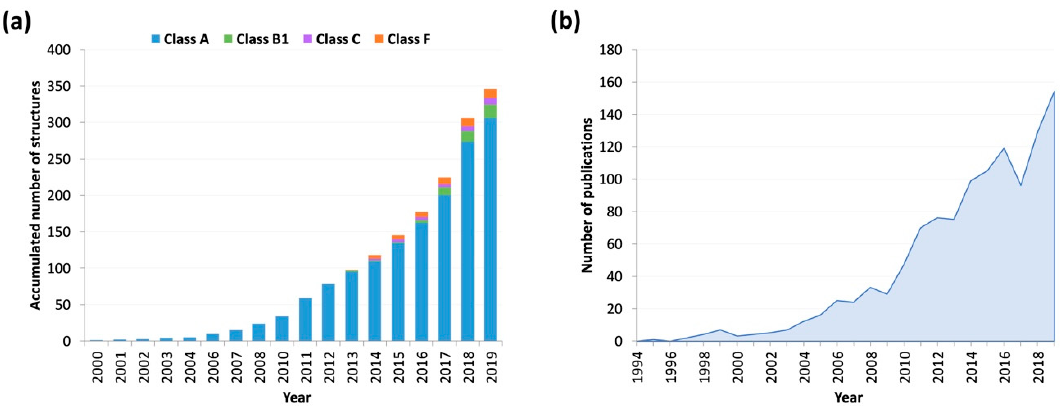
Figure 1. ( a ) Number of G protein-coupled receptors (GPCRs) structures available in GPCRdb [4,5] over time. ( b ) Number of publications per year indexed at Thomson Reuters’ Web of Science that contain the topics “molecular dynamics” and (“GPCR” or “GPCRs”). The exponential growth of successful GPCR research based on molecular dynamics (MD) simulations is evidenced by the rapid upsurge in the number of publications per year related to this subject.